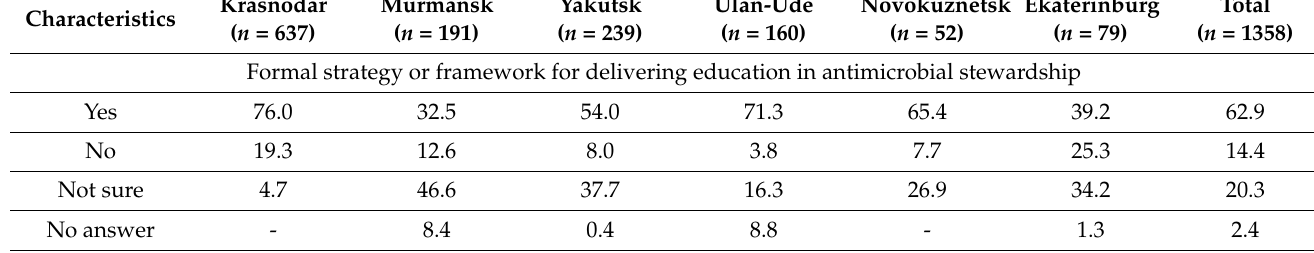
Table 5. Organization of antimicrobial stewardship teaching at the institution level, %.